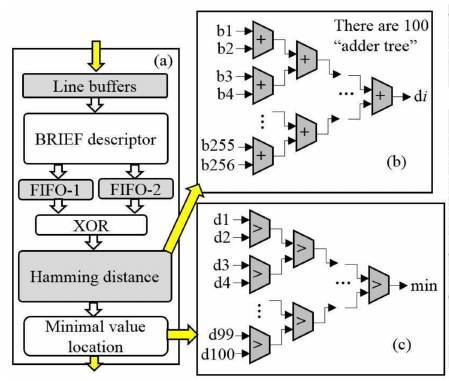
Figure 9. Matching module, ( a ) matching processing; ( b ) adder tree; ( c ) finding minimum